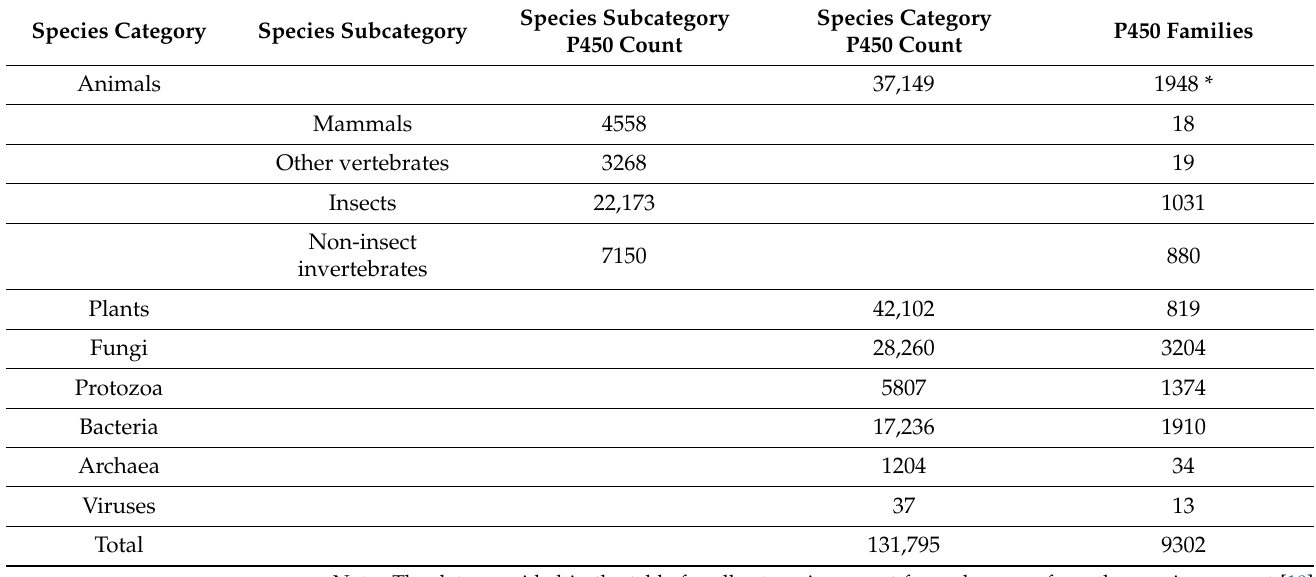
Table 1. Comparative analysis of P450s and their families in species across biological